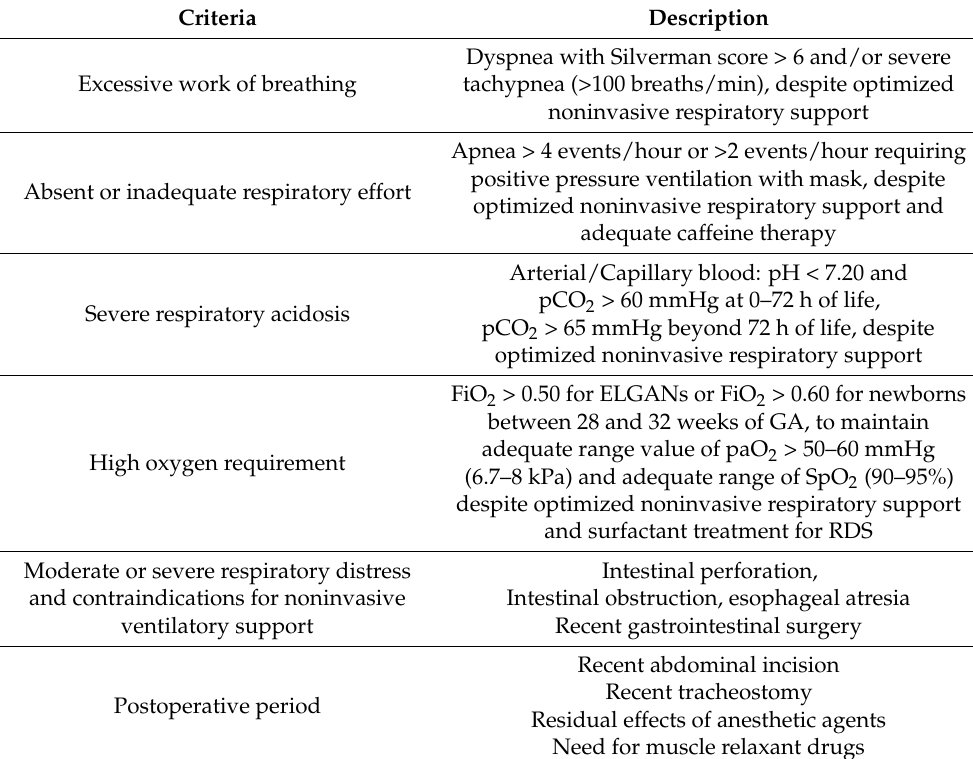
Table 1. Suggested indications for intubation and mechanical ventilation in preterm infants: presence of at least one of the following